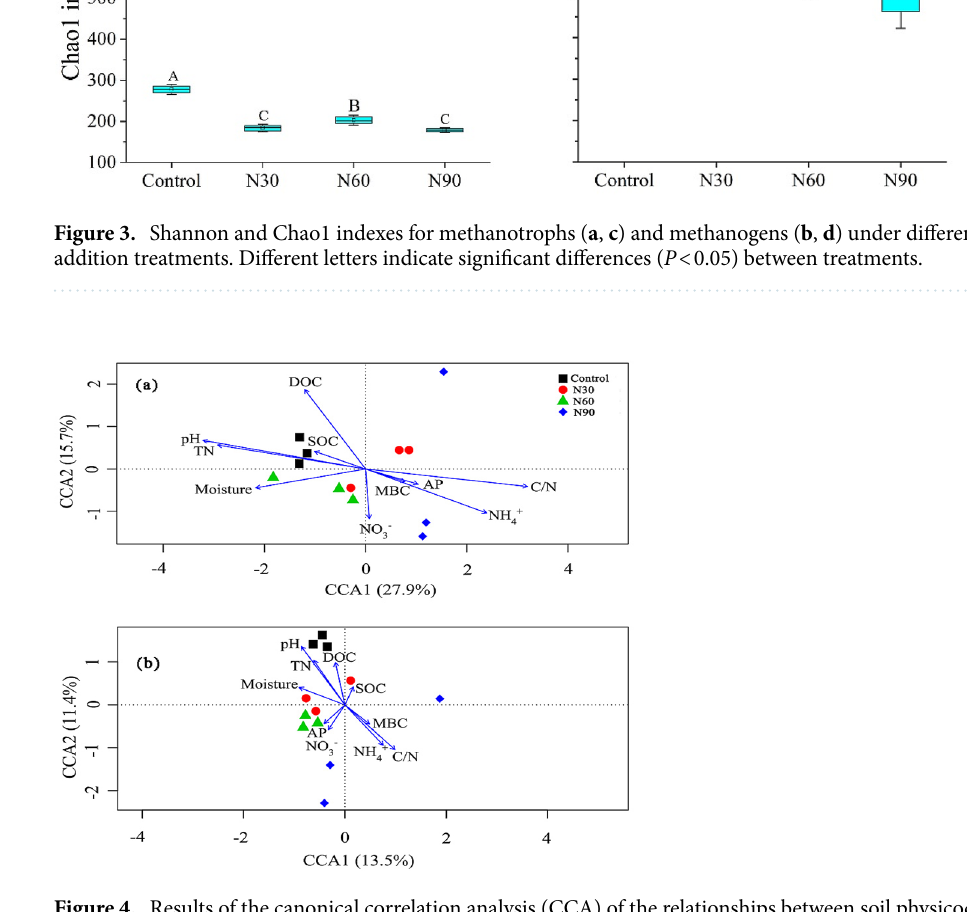
Figure 4. Results of the canonical correlation analysis (CCA) of the relationships between soil physicochemical properties and methanotroph ( a ) and methanogen ( b ) community structure in all